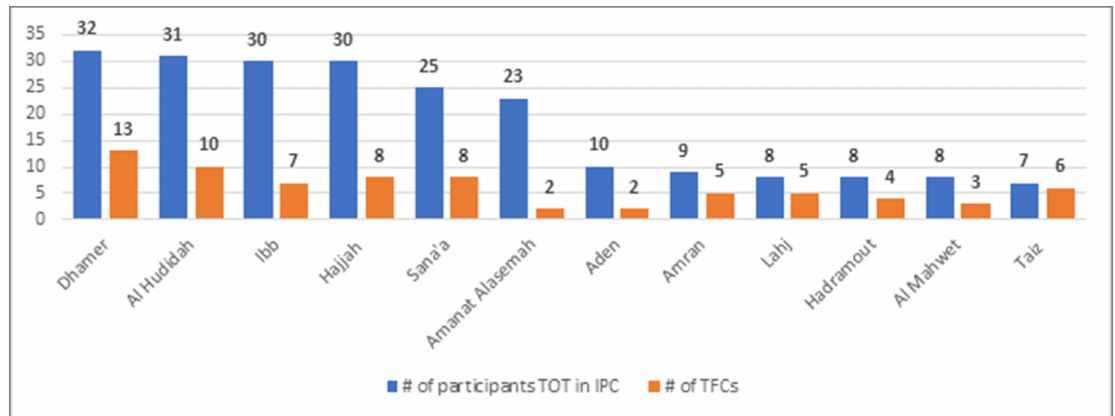
Figure 5. Number of TFCs implementing IPC counseling per governorate and number of participants who participated in training of trainers on IPC. Abbreviations: IPC: infection protection and control; TFCs: therapeutic feeding centers; TOT: training of trainers.